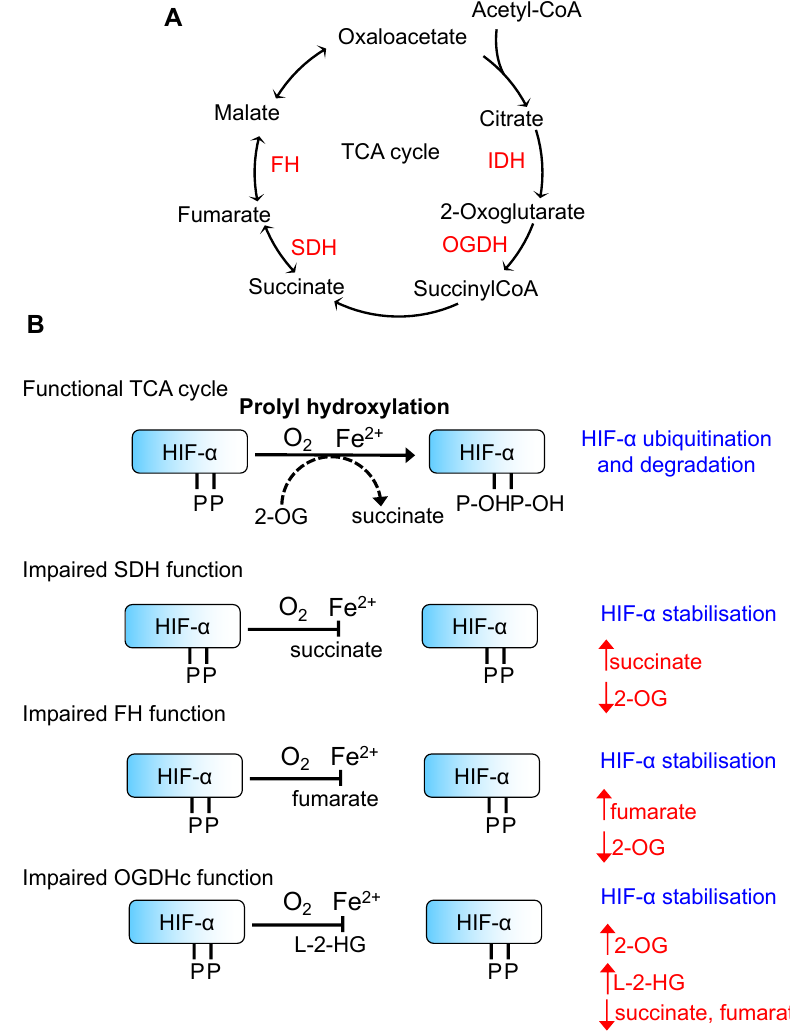
Figure 1: TCA cycle metabolites and HIF-α prolyl hydroxylation